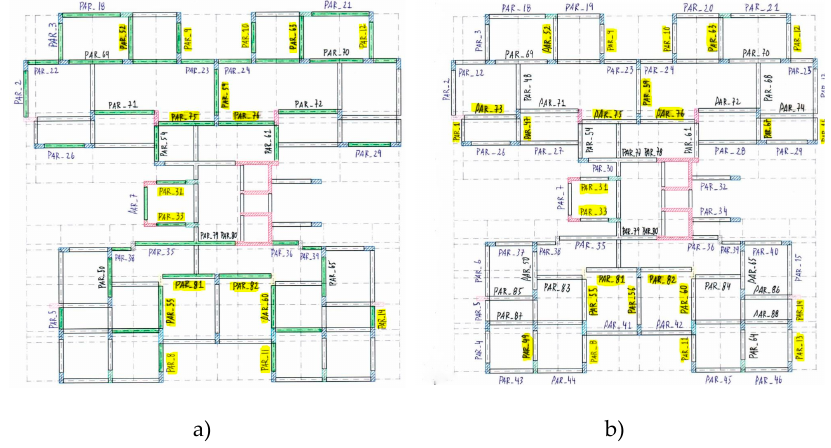
Figure 4. Distribution of the infill masonry walls: ( a ) ground floor; and ( b ) remaining floors. Where Par_€ means infill panel number €.